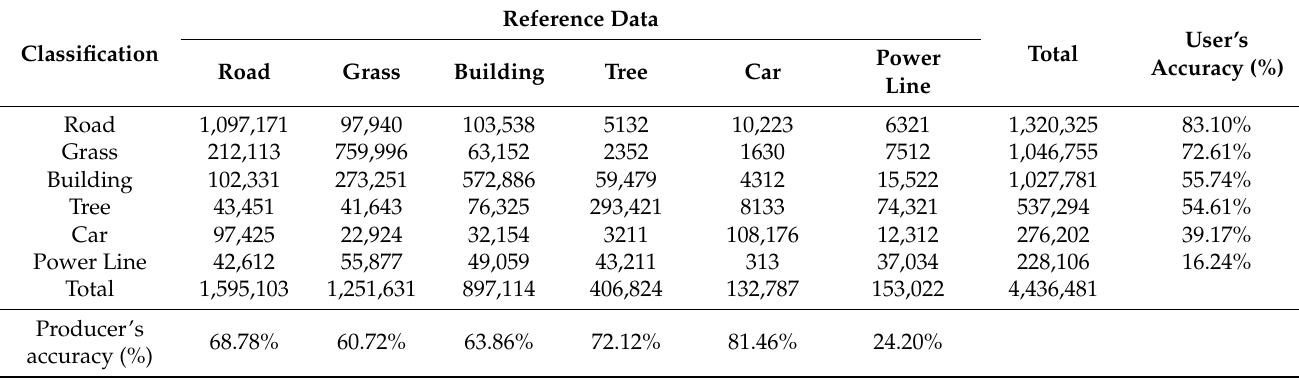
Table 5. Point cloud classification confusion matrix for method (a).